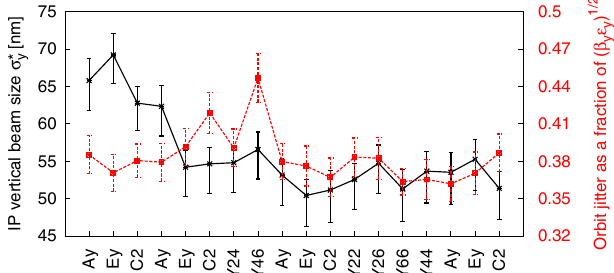
FIG. 10. IP vertical beam size (black) and the orbit jitter (red) versus the beam tuning in half β (cid:1) y , 25 β (cid:1) x optics. Points represent- ing the beam size correspond to the optimum knob setting and error bars account for the uncertainty of finding the optimum knob setting by fitting the knob scan data (as in Fig. 6) and for the systematic error of Shintake monitor as described in Sec. II C.